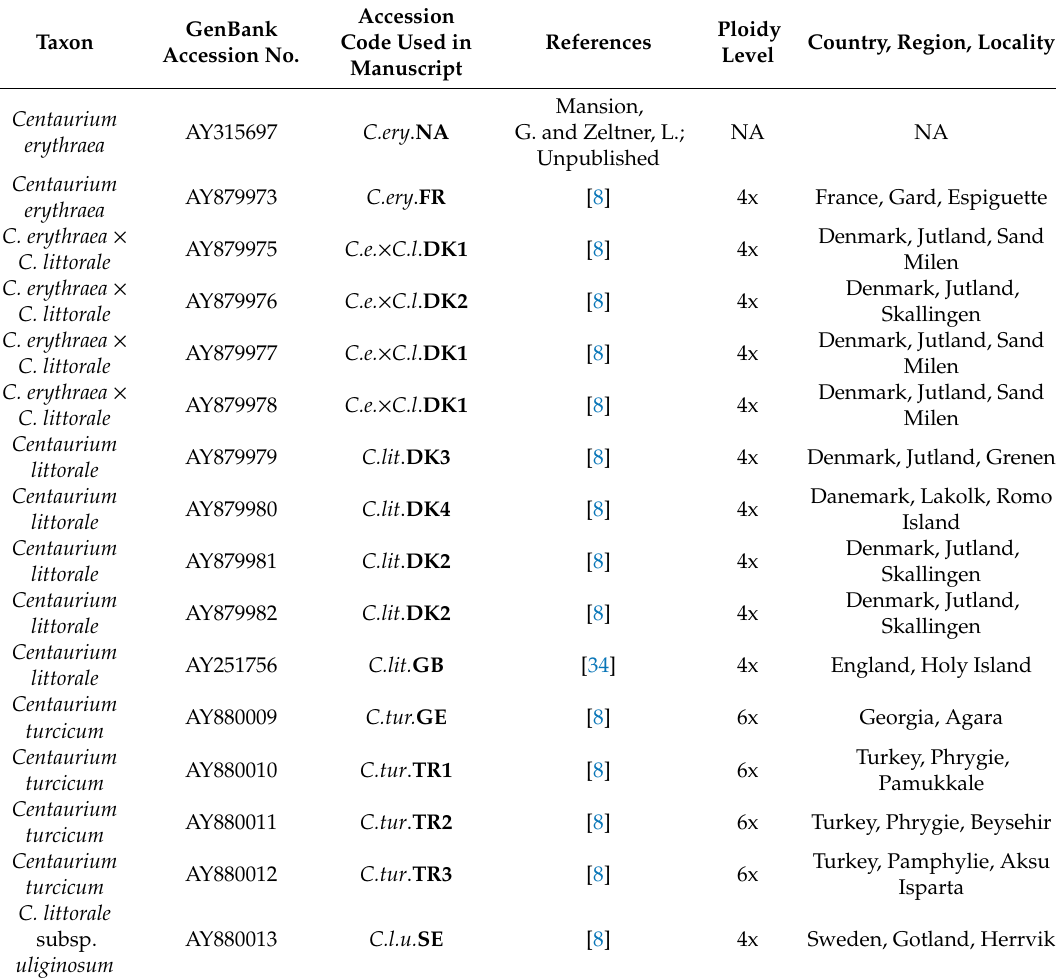
Table 4. Origin of plant material, reference information and GenBank accessions for DNA sequences used for comparison of trn L-F